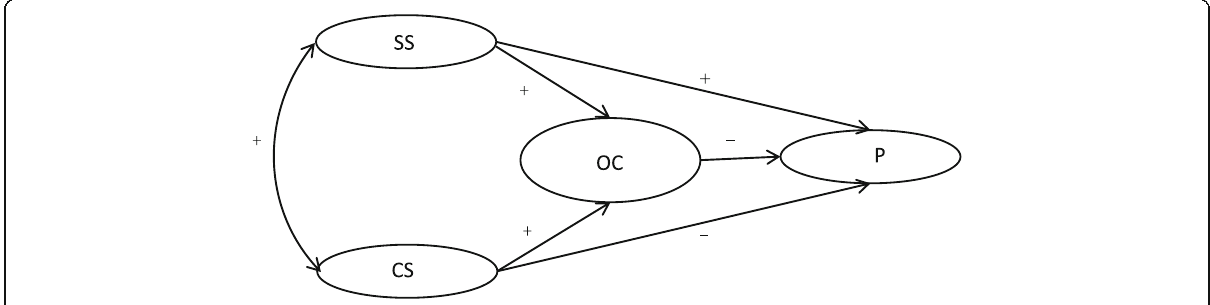
Fig. 1 Proposed model of how supervisor support (SS), coworker support (CS), and organizational commitment (OC) affect presenteeism